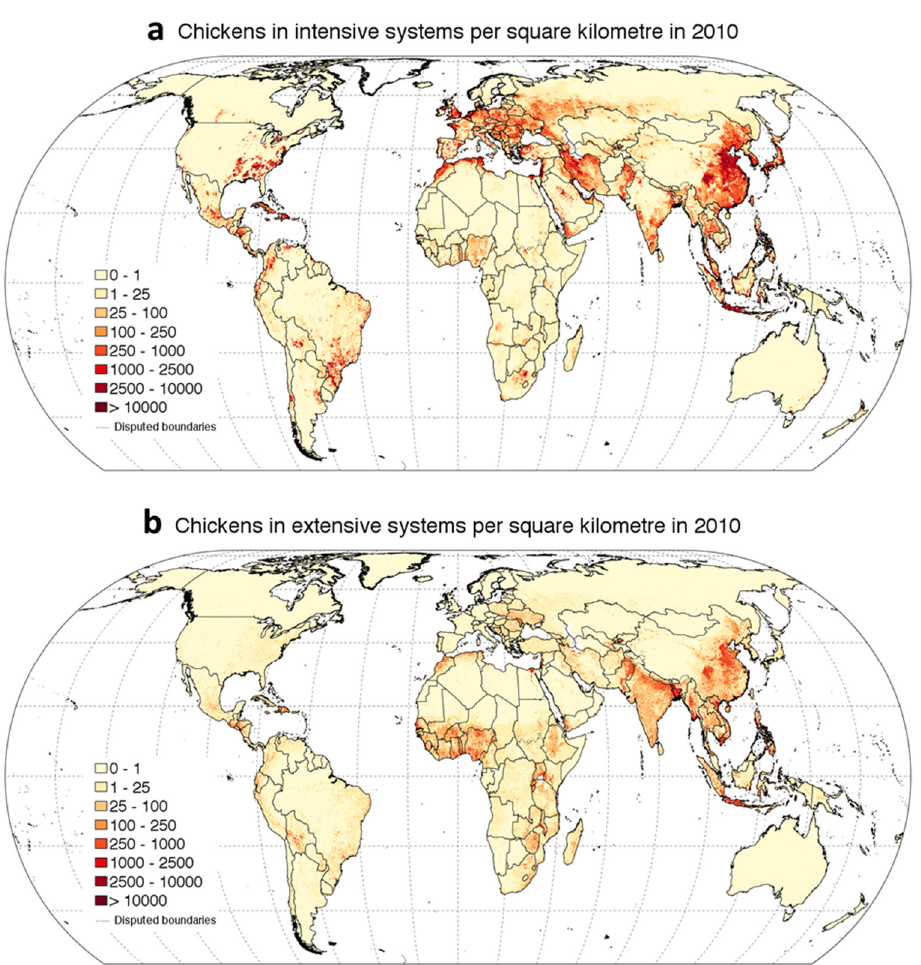
Figure 2. These figures represent the global distribution of chicken in 2010 in intensive ( a ) and extensive ( b ) systems (source: figure taken from https://dataverse.harvard.edu/dataset.xhtml?persistentId = doi:10.7910/DVN/A7GQXG and adapted for illustrative purpose only).